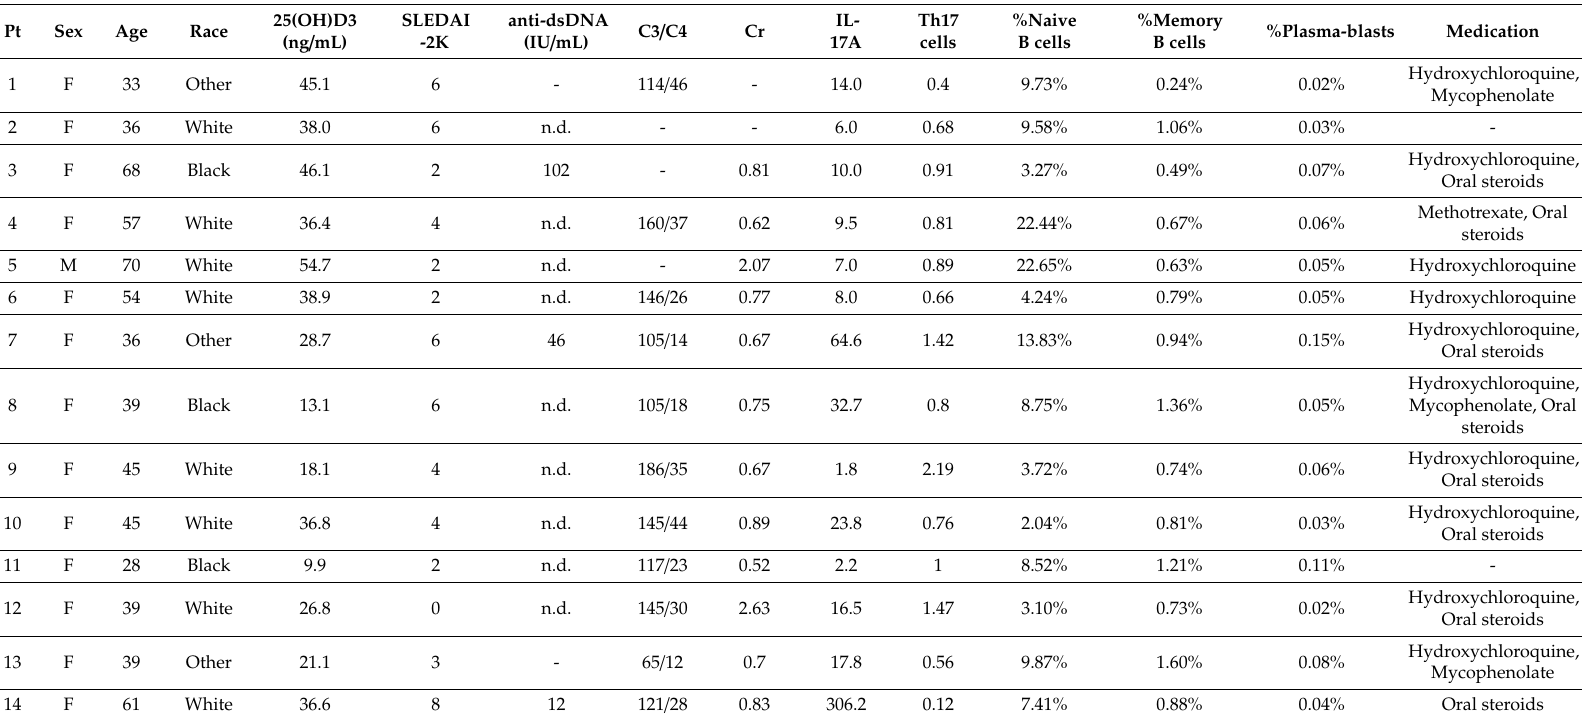
Table 2. Systemic Lupus Erythematosus (SLE) patient